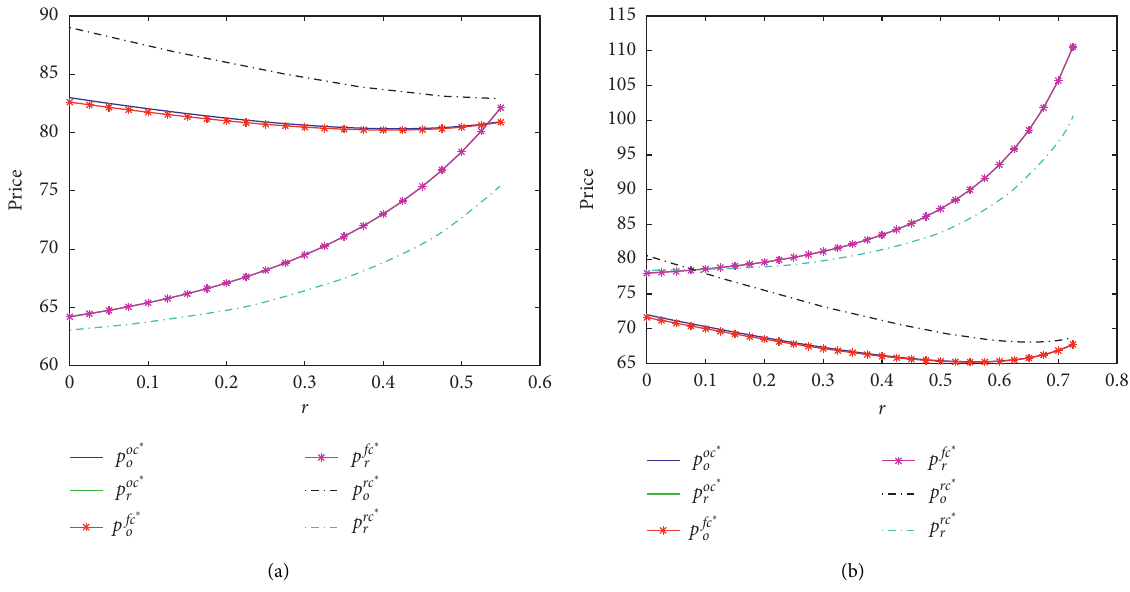
Figure 7: Effect of r on channel prices under different θ : (a) low θ ( θ � 0 . 35); (b) high θ ( θ � 0 .